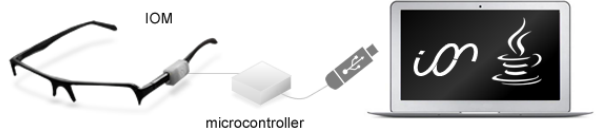
Figura 1. IOM basic operating scheme. Source: Cardoso et al.